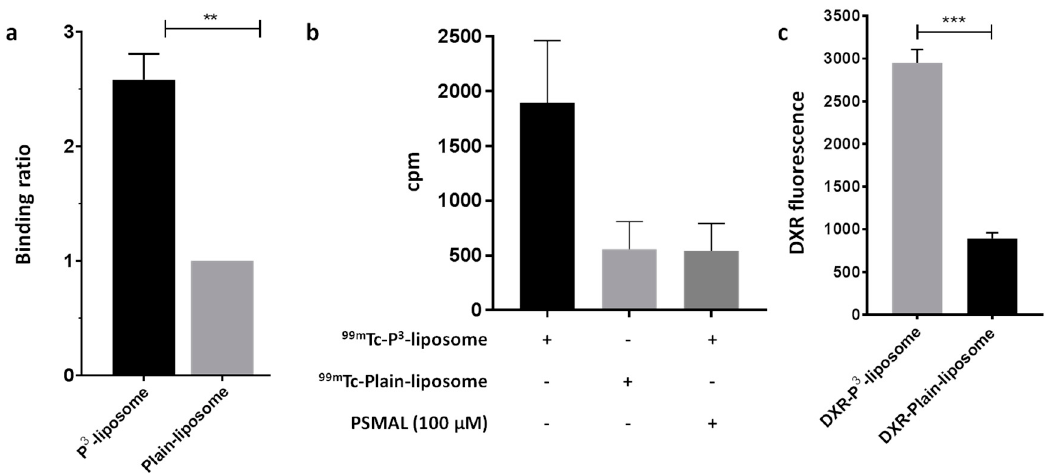
Figure 7. ( a ) Binding of 99m Tc-P 3 -liposomes and 99m Tc-Plain-liposomes to PSMA-column. ( b ) Interaction of 99m Tc-P 3 -liposomes and 99m Tc-Plain-liposomes with LNCaP cells in the presence and absence of unlabeled P 3 . ( c ) Delivery of doxorubicin by P 3 -liposomes and Plain-liposomes in LNCaP cells (** p = 0.0022, *** p = 0.0003).